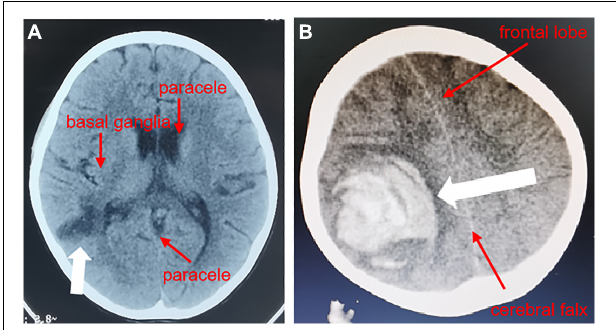
FIGURE 1 | Head CT of the pediatric patient. In the CT results of the head from another hospital, a transverse plane through the inferior portion of the parieto-occipital sulcus showed a hypodense shadow next to the posterior horn of the right ventricle (A) , and on the 36th day of hospitalization, a transverse plane through the center of the hemioval showed a right parietal hematoma with herniation of the cerebral sickle (B) .